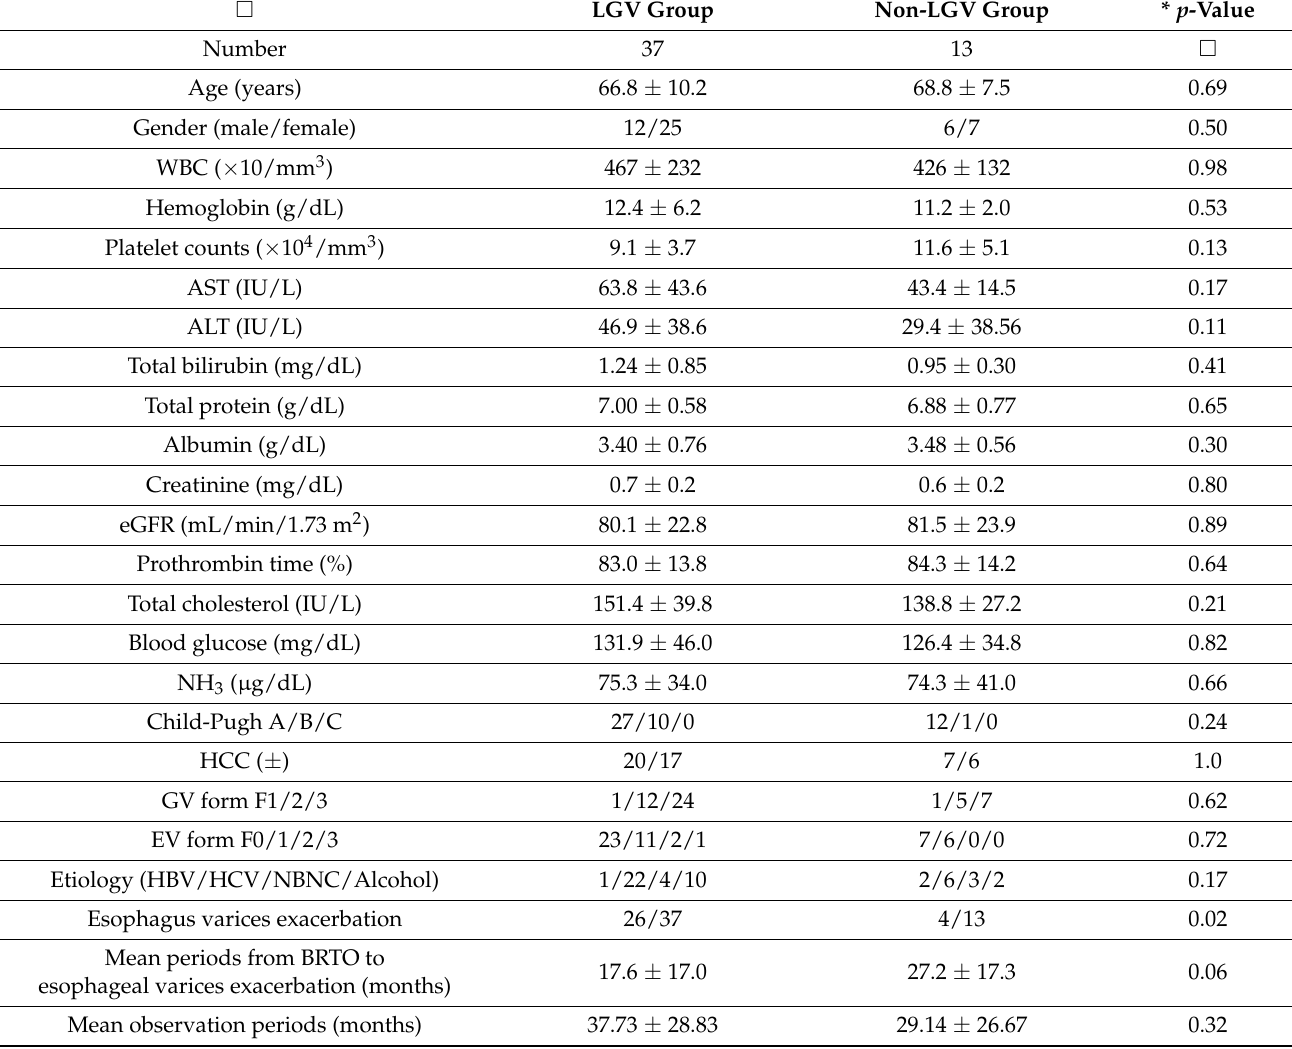
Table 2. Comparison of patients’ background between left gastric vein (LGV) and non-LGV